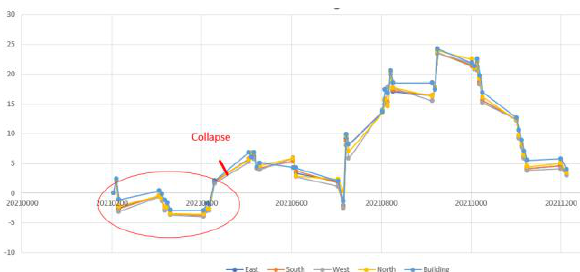
Figure 16. Displacement on Building 4 location, and its neighbours.